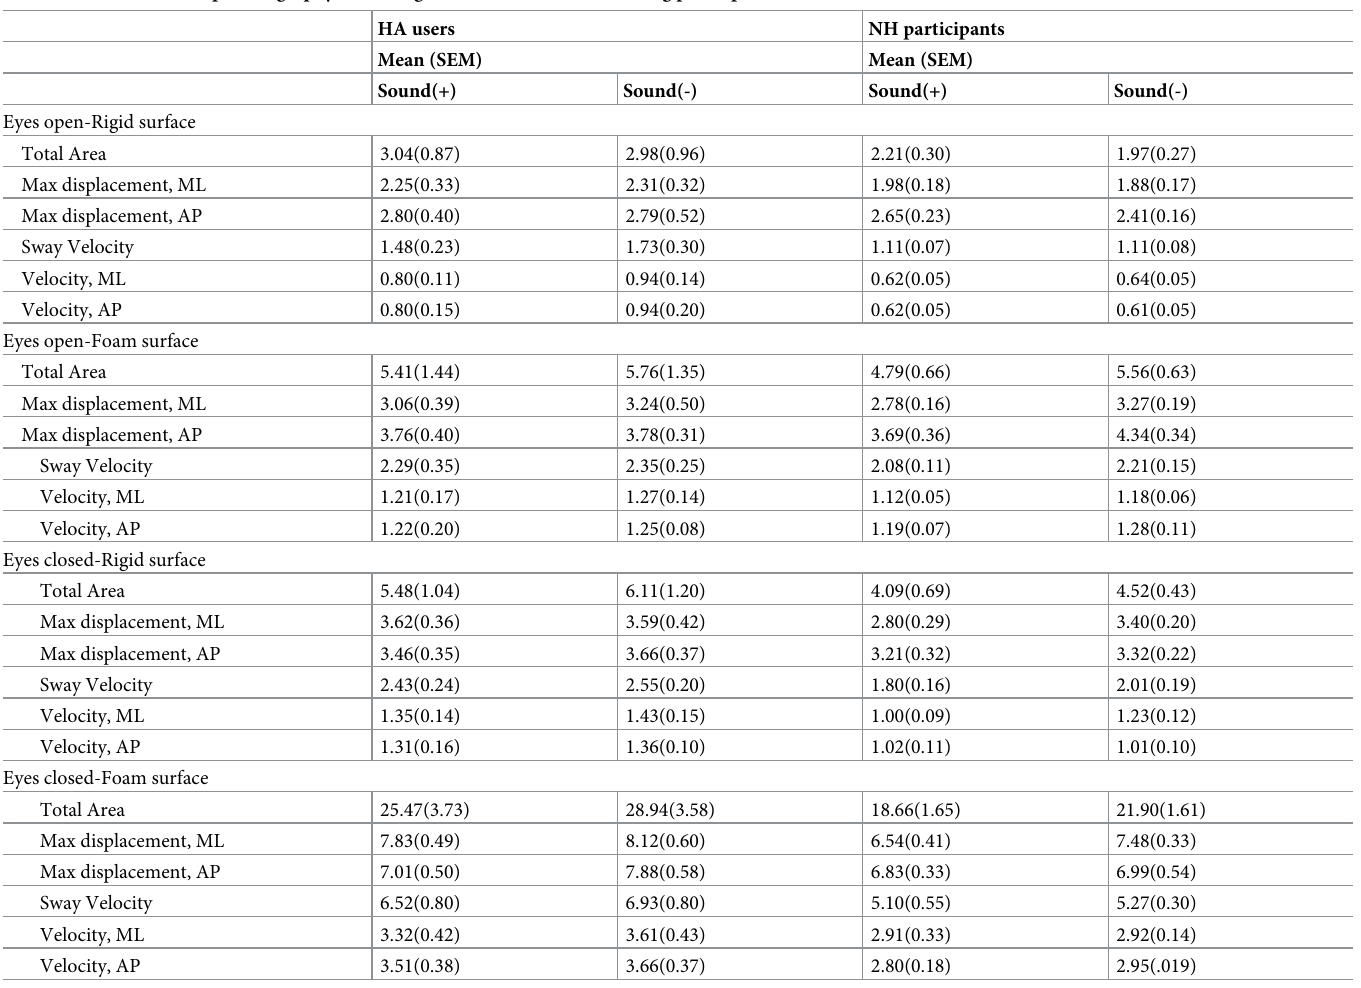
Table 2. Results of static posturography in hearing aid users and normal-hearing